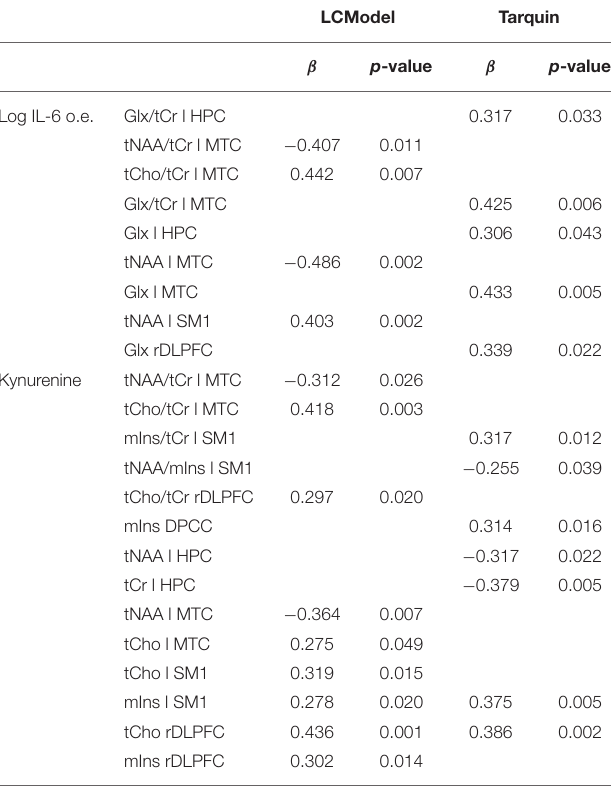
TABLE 5 | The effect of inflammatory blood markers adjusted for age, sex and fat% on neurometabolites. LCModel